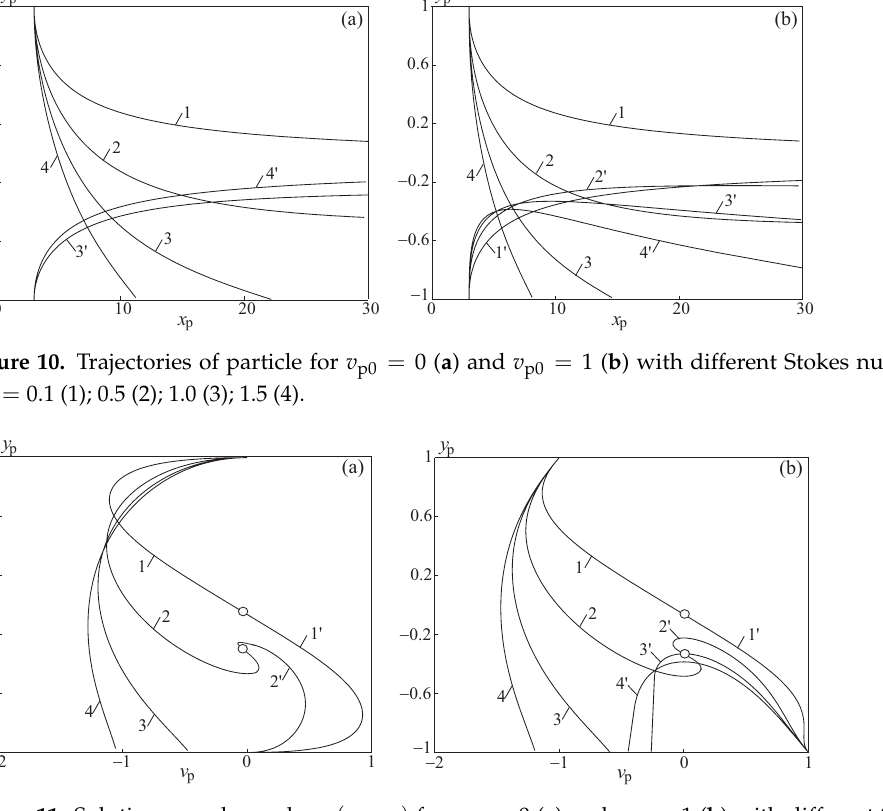
Figure 11. Solutions on phase plane ( v p , z p ) for v p0 = 0 ( a ) and v p0 = 1 ( b ) with different Stokes numbers Stk = 0.1 (1); 0.5 (2); 1.0 (3); 1.5